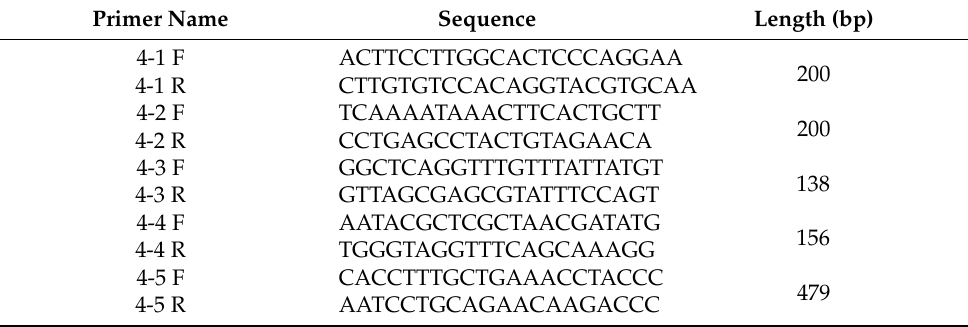
Table 3. Primers for ChIP-qPCR of IE genes ICP4 promoter of